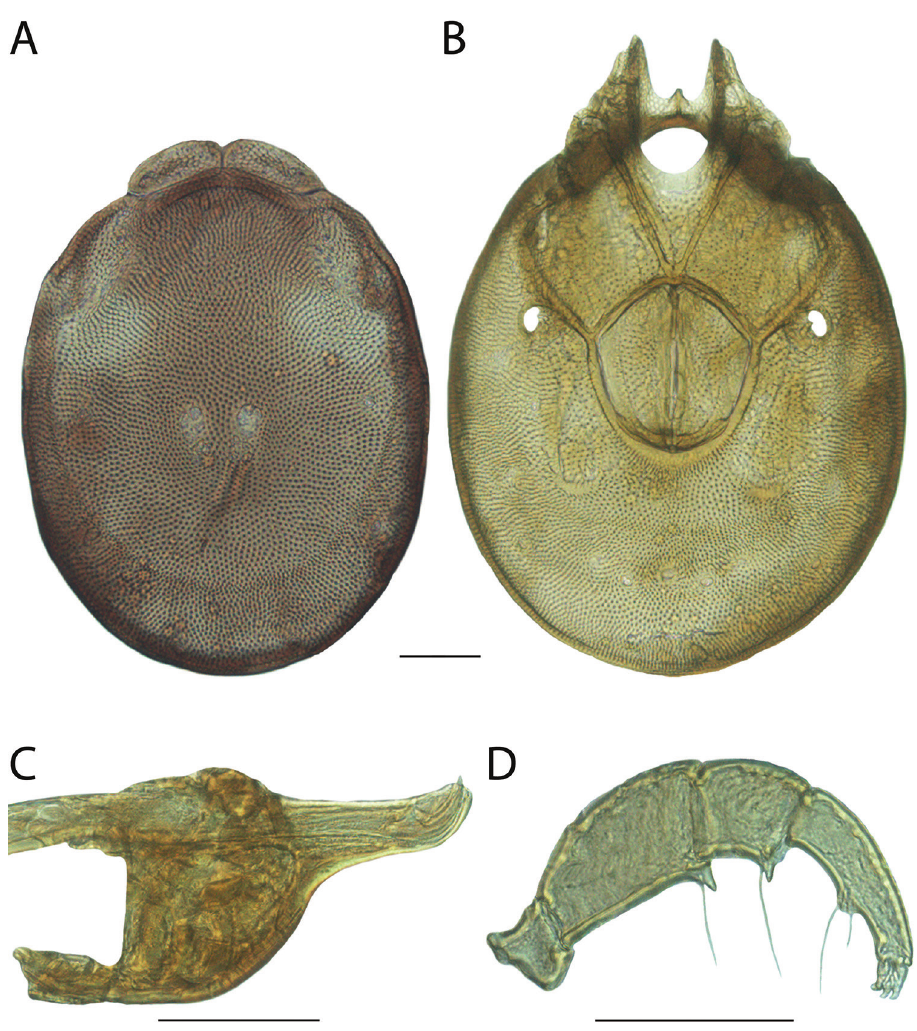
Figure 97. Torrenticola indistincta female: A dorsal plates B venter (legs removed) C subcapitulum D pedipalp (setae not accurately depicted). Scale = 100